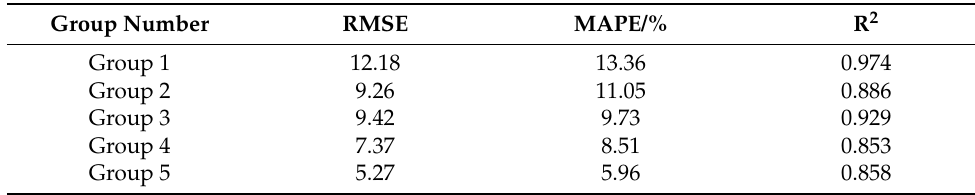
Table 3. Accuracy evaluation of plant height calculation of